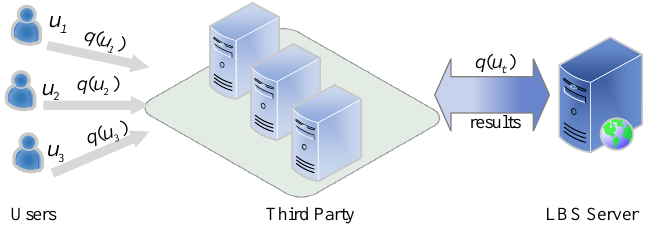
Figure 3. The architecture with a third party.